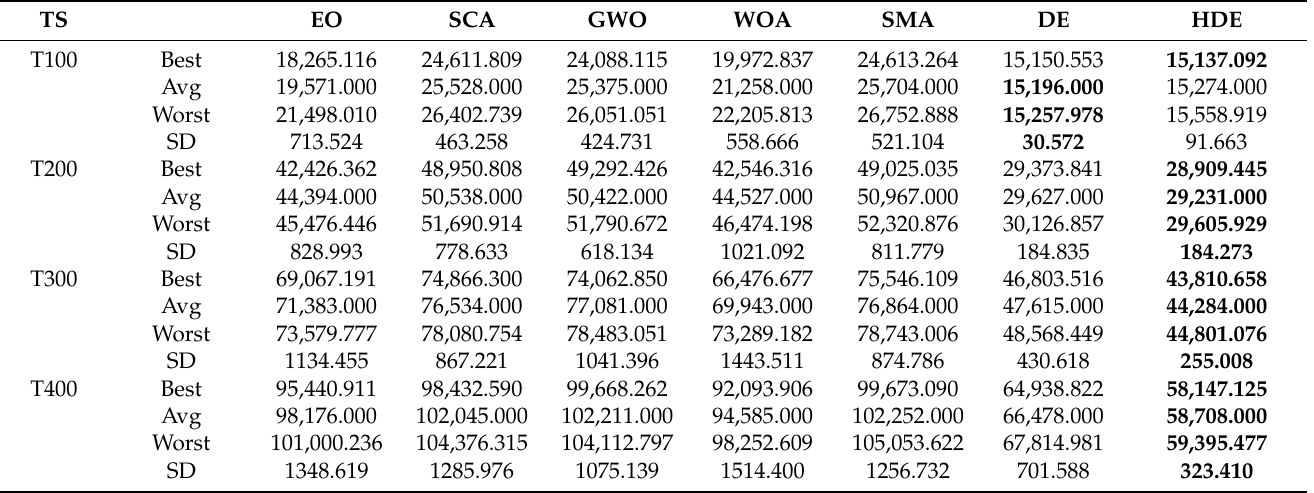
Table A1. Comparison with some metaheuristic algorithms for the fitness